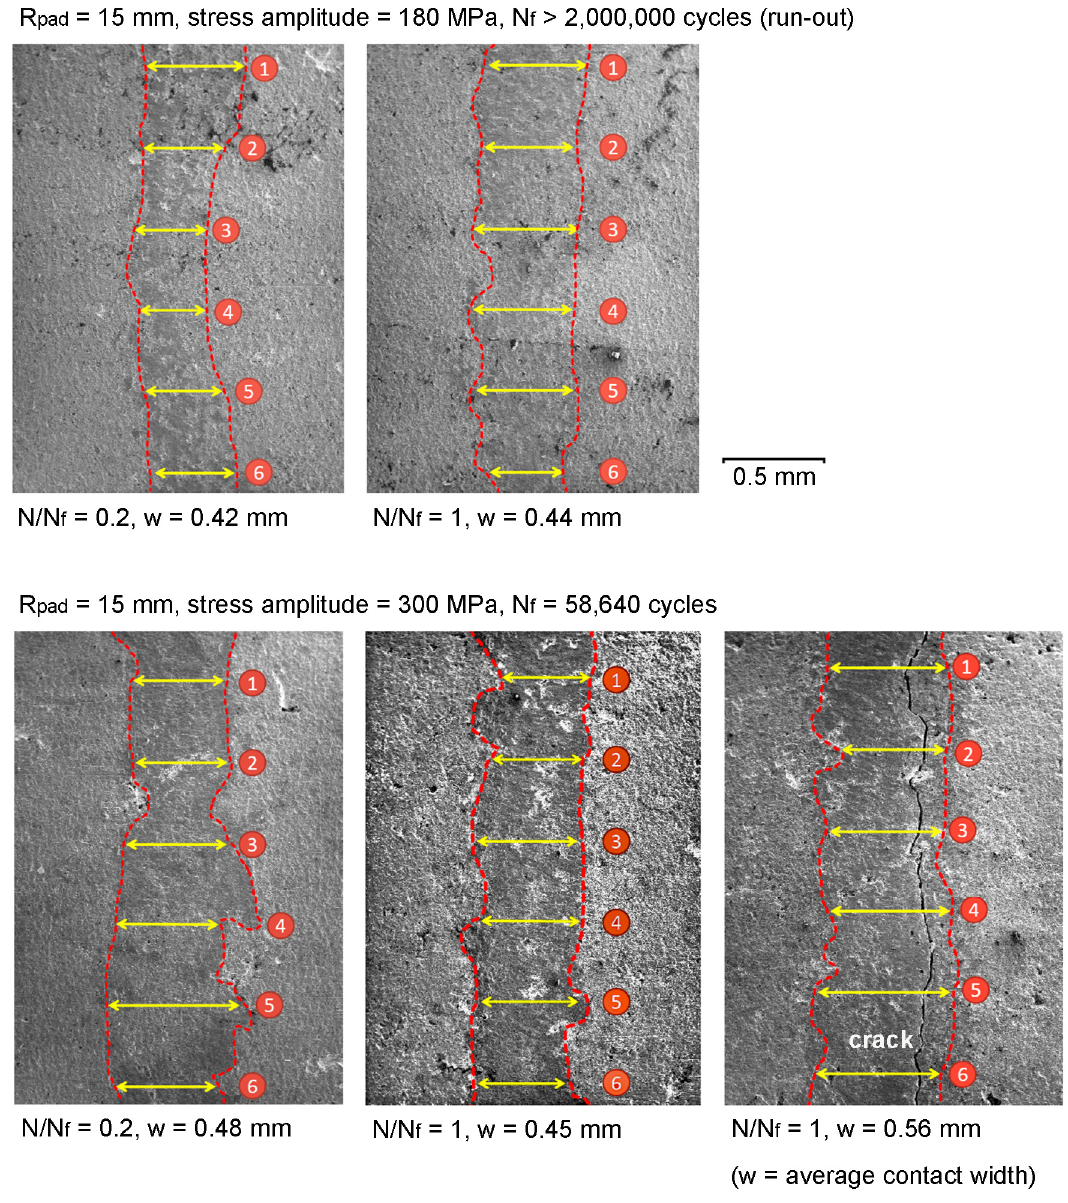
Figure 3. Contact marks on fretting fatigue specimens ( R pad = 15 mm) tested at stress amplitudes of 180 MPa and 300 MPa (bulk alternating stress is in horizontal direction).